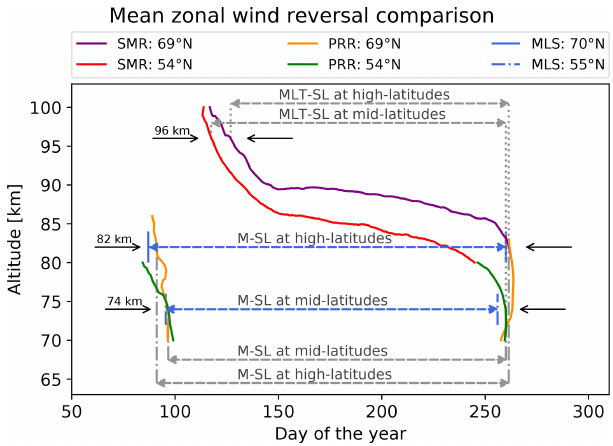
Figure 2. Mean zonal wind reversal comparison and summer length definitions (MLT-SL and M-SL) at high and middle latitudes. The mean zonal wind reversal (0ms − 1 ) extracted from the climatolo- gies from SMRs (purple) and PRR (orange) at 69 ◦ N and SMRs (red) and PRR (green) at 54 ◦ N. In addition, the specific geopoten- tial heights with the zero zonal mean geostrophic zonal wind values from the MLS (blue) are shown at 70 ◦ N (solid line) and at 55 ◦ N (dash-dotted line). The black arrows indicate the altitude taken for the mean zonal wind reversal used in the individual